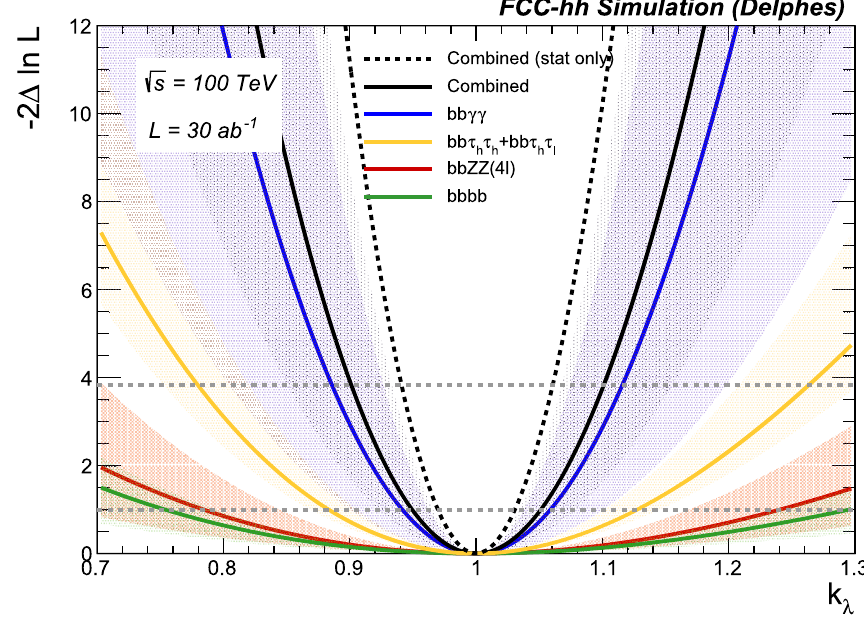
Fig. 13 Expected negative log-Likelihood scan as a function of the trilinear self-coupling modifier κ λ = λ /λ SM in all channels, 3 3 and their combination. The solid line corresponds to the scenario II for systematic uncertainties. The band boundaries represent respectively scenarios I and III. The dashed line represents the sensitivity obtained including statistical uncertainties